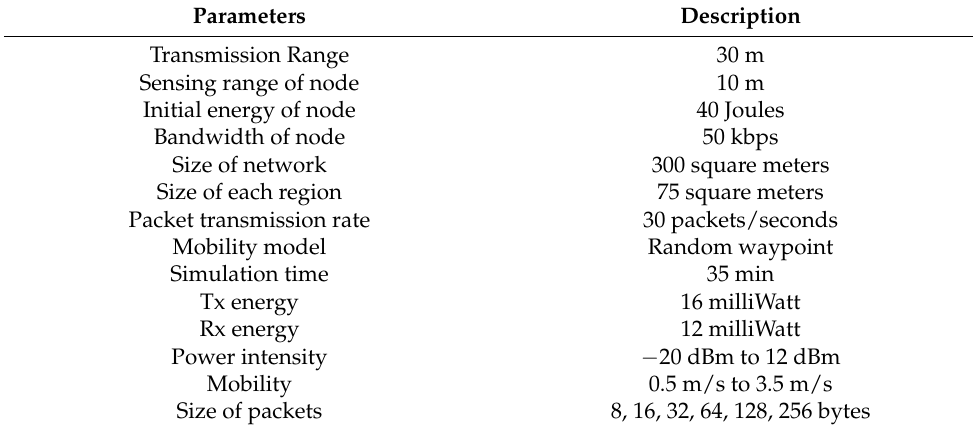
Table 1. Parameters of the